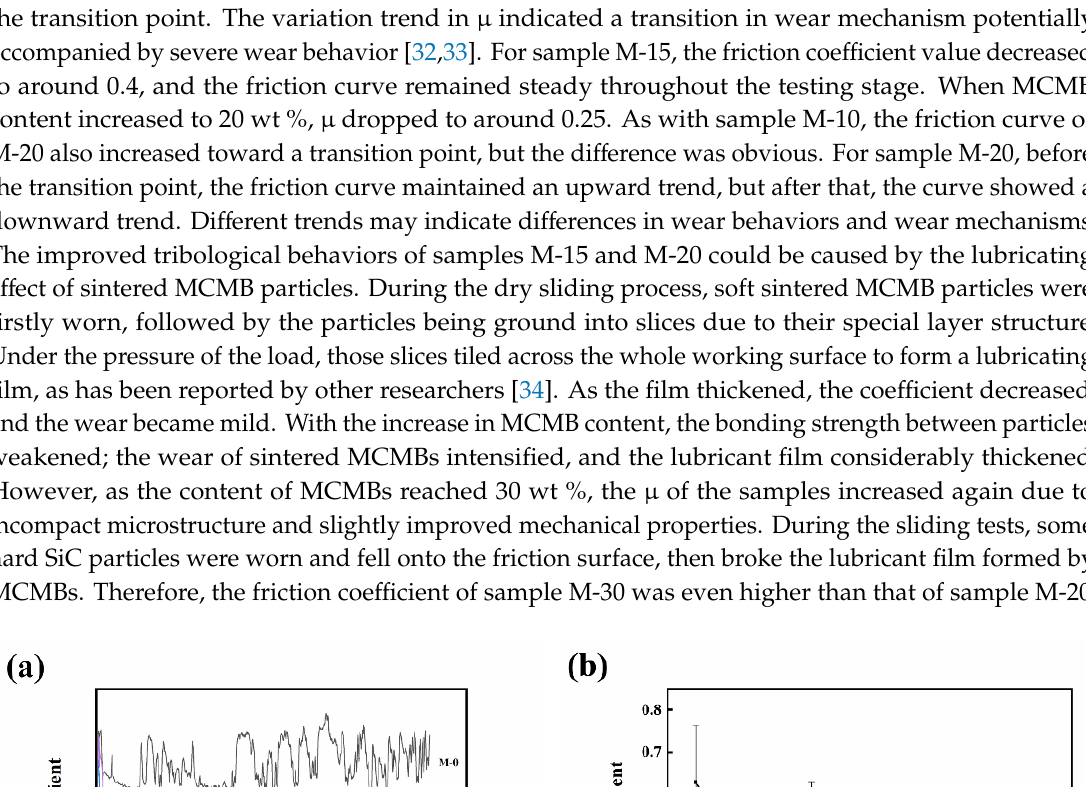
Figure 9. Relationship between MCMB content of the samples and wear rate.